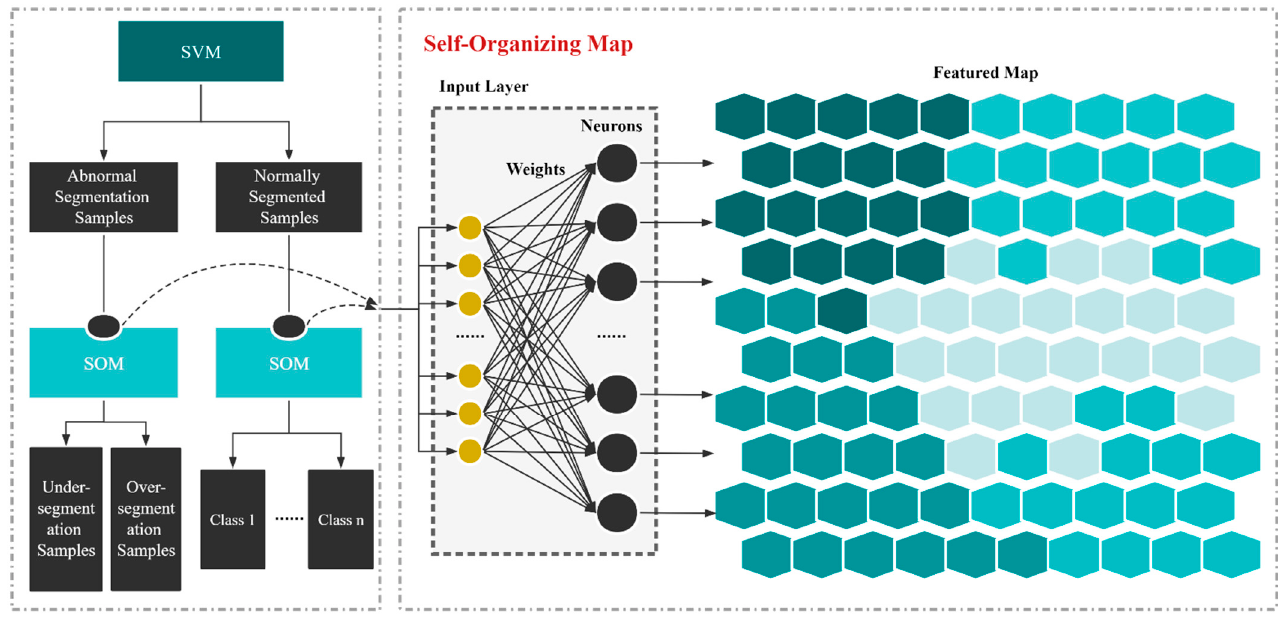
Figure 5. Sample classification flow.